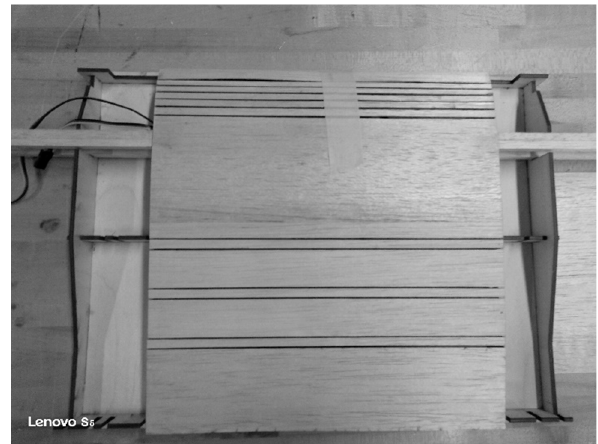
Figure 10. Central section of the wing corresponding to the MCS.